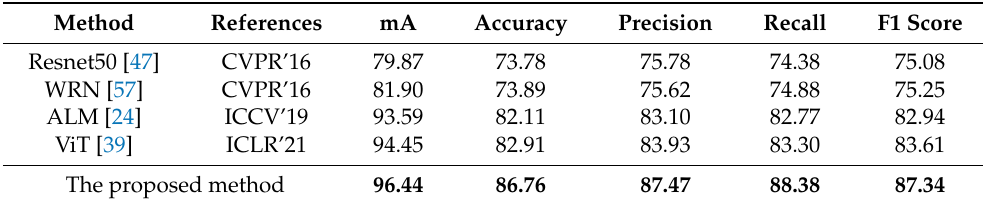
Table 3. The attribute recognition results on our proposed safety attribute recognition subdataset. Best results are shown in